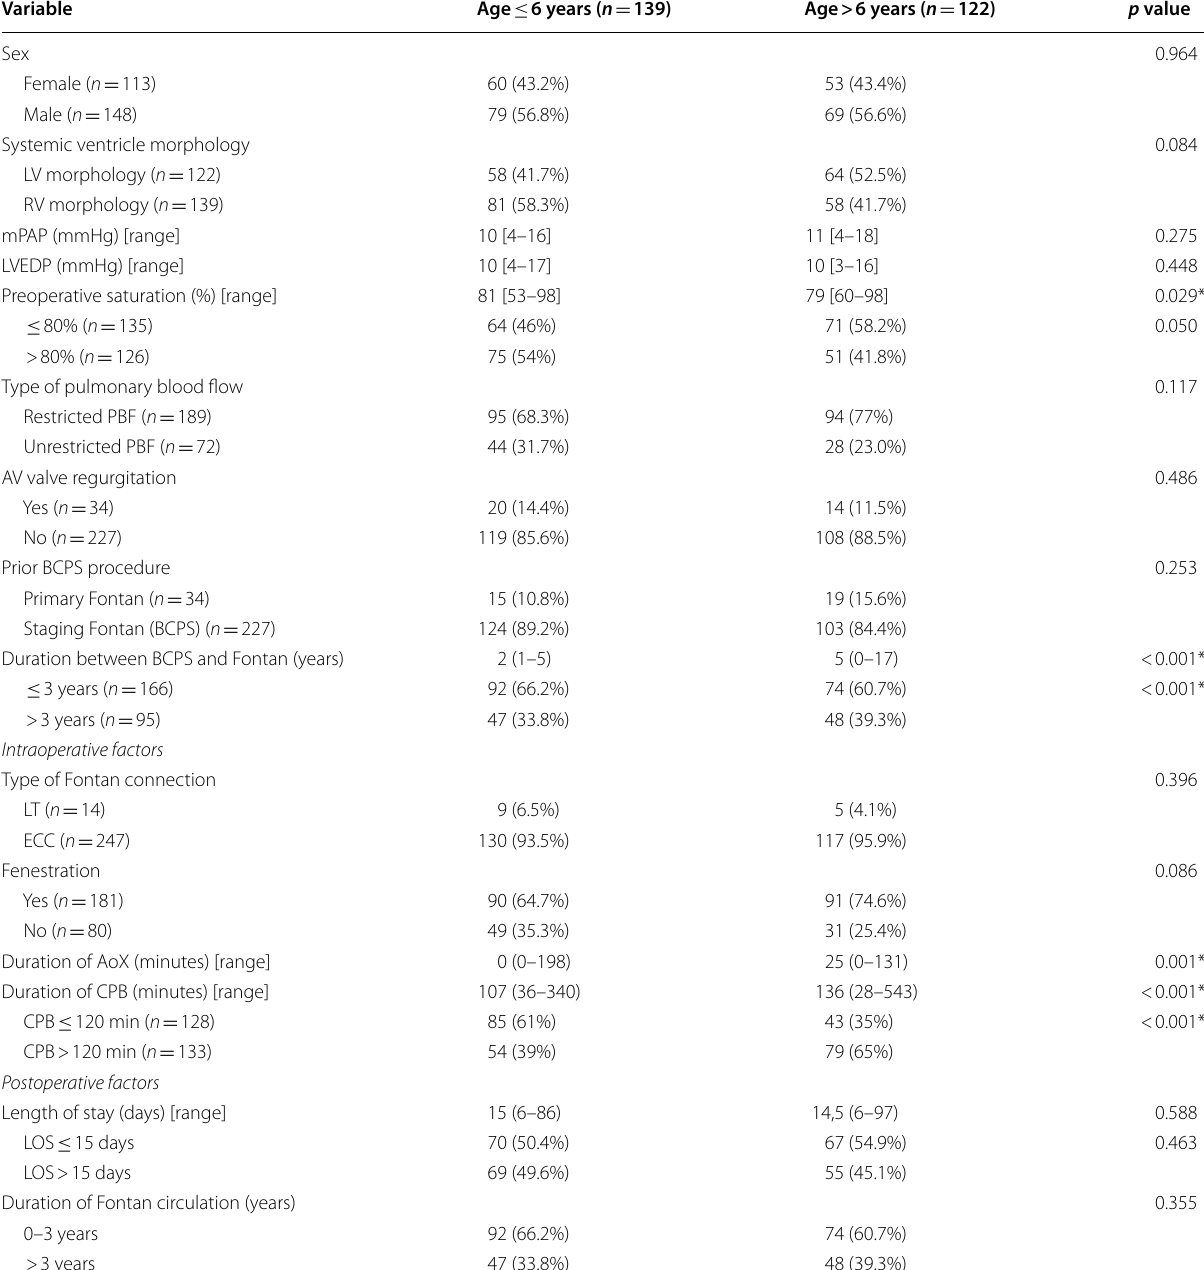
Table 1 Baseline characteristics of 261 patients underwent a Fontan